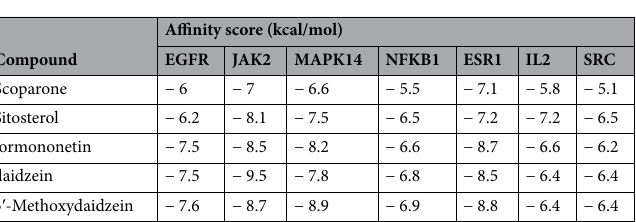
Table 2. Affinity score of the screened 5 ligand molecules to 7 receptor proteins.